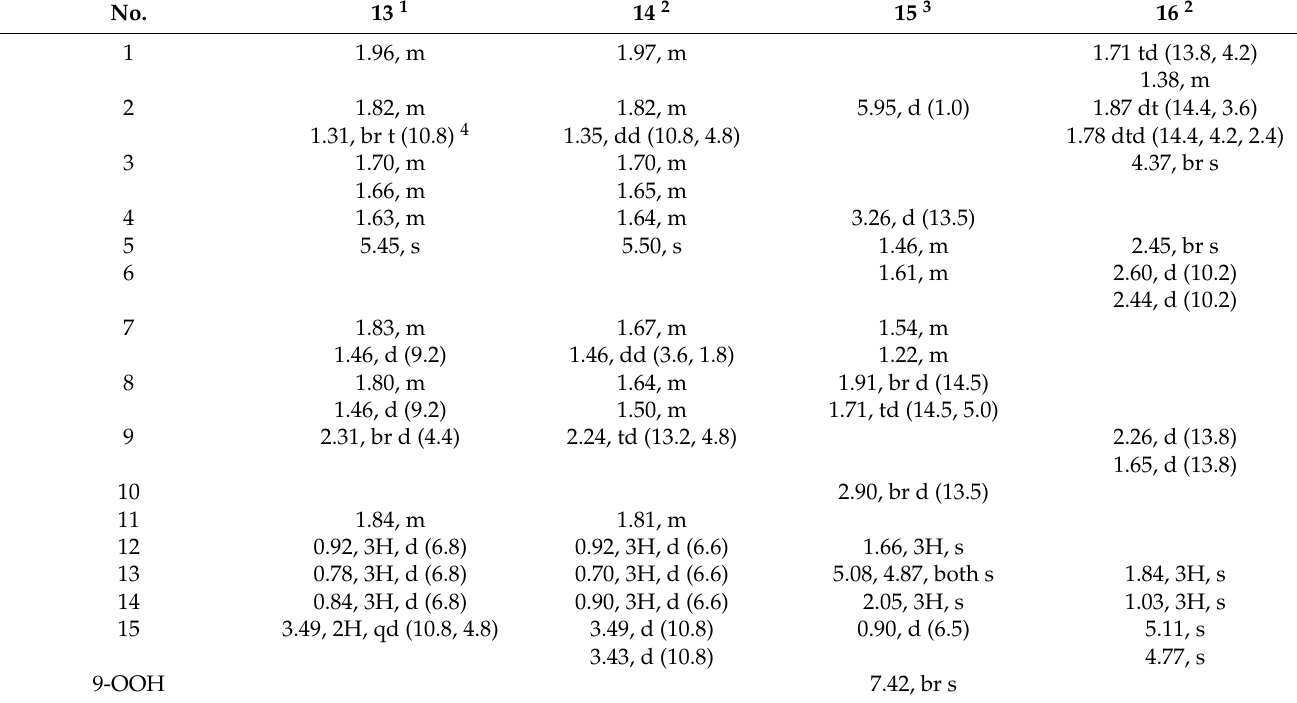
Table 7. 1 H NMR spectroscopic data of compounds 13 – 16